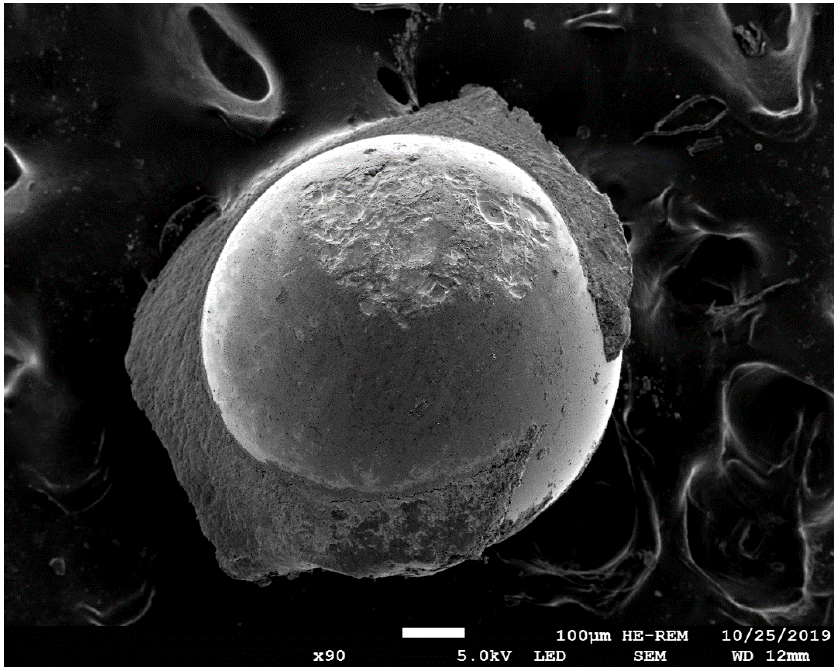
Figure 9. Example of severely damaged GB ( high index , sample HI ) after 6720 drum rotations. SEM image (magnification 90×).